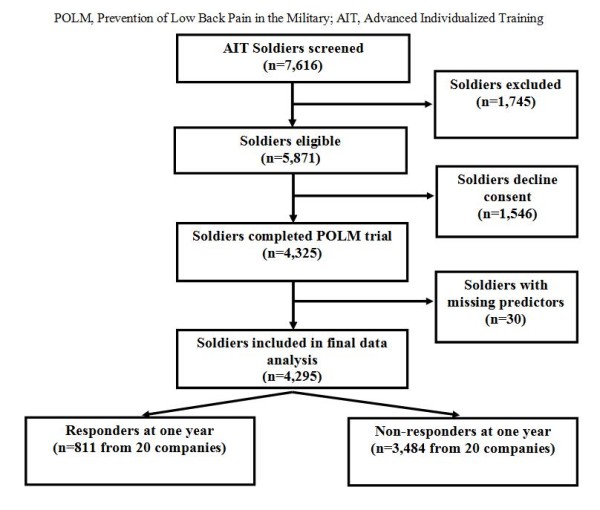
Flow diagram for subject recruitment and email responders one year after the conclusion of the study.